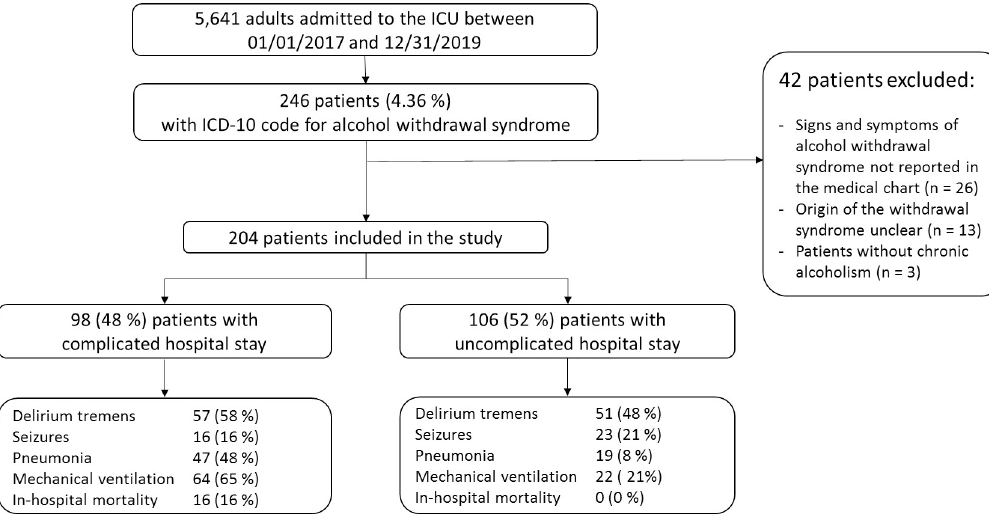
Fig 1. Study flowchart. ICD-10: International Classification of Diseases 10 th